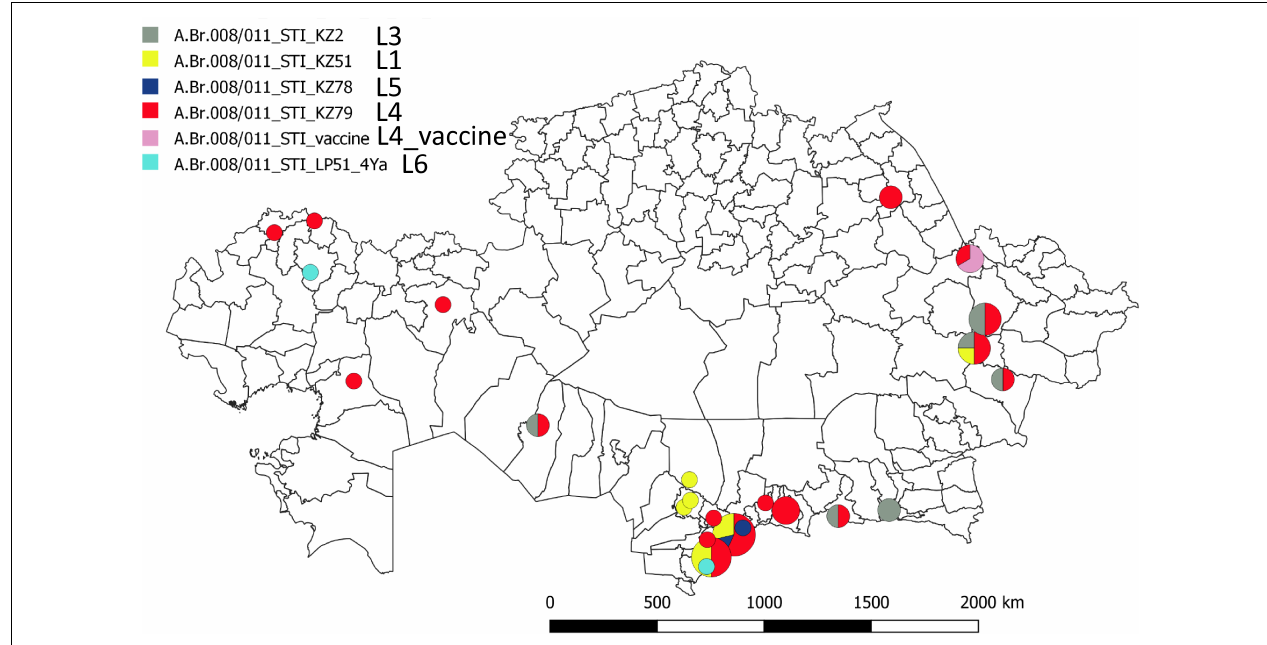
FIGURE 2 | Geographic distribution of the STI sublineages across Kazakhstan. The geographic location of the fifty representative STI strains is indicated at district level resolution. The color code reflects the assigned STI sublineage. Turkistan (South Kazakhstan) region next to the ancient trade routes shows the highest concentration and genetic